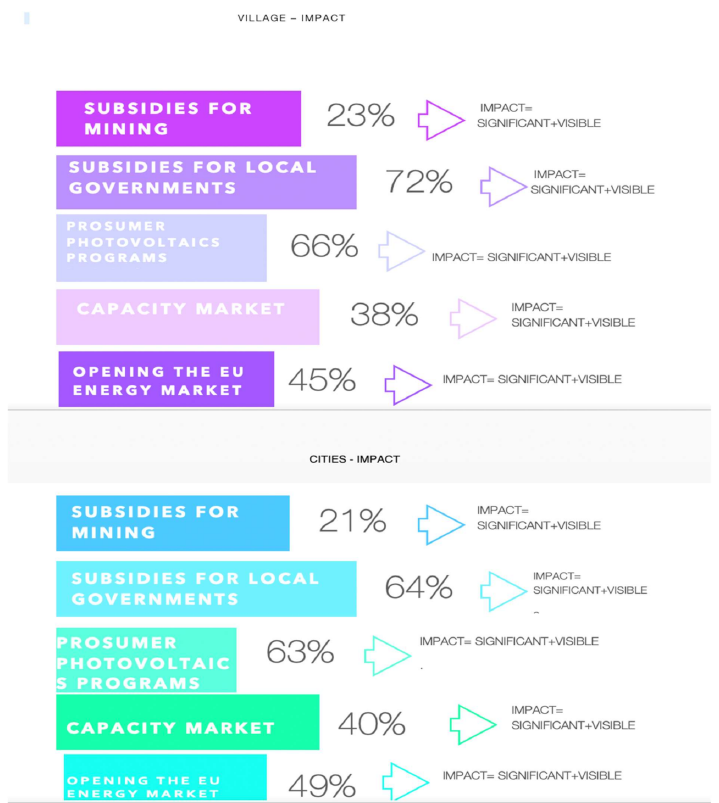
Figure 1. Respondents’ opinions on the activities determining decarbonization